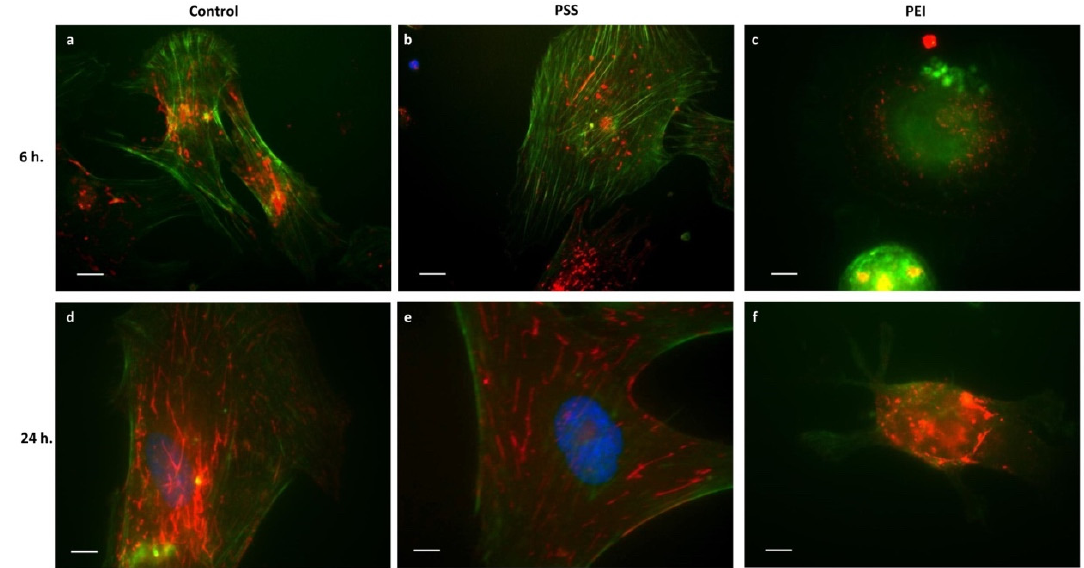
Figure 4. Distribution of Integrin α 5ß1 (red fluorescence) and actin (green fluorescence) in MSCs after 6 h and 24 h of culture time on glass slides ( a , d ), PSS-ended slides ( b , e ), and PEI-ended ( c , f ) slides Blue represents DAPI stain of nuclei. Scale bar: a and b = 5 μ m.